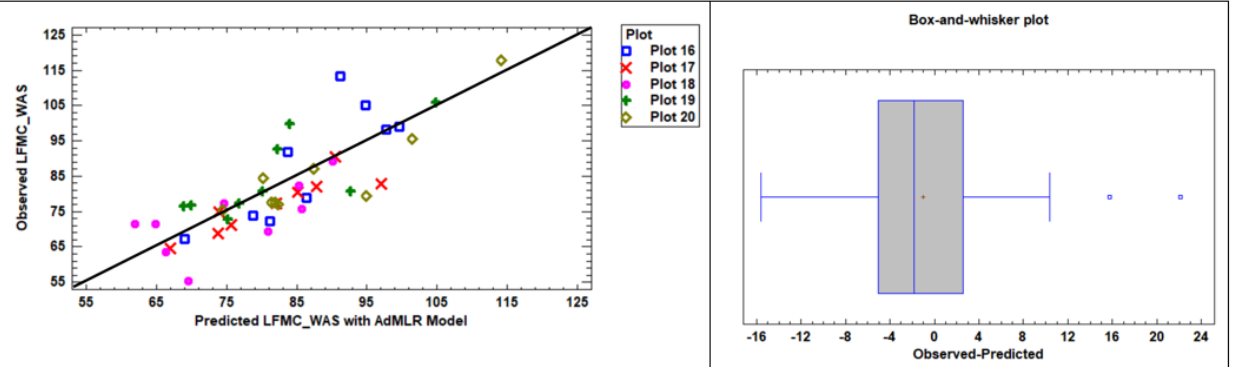
Figure 8. Scatterplot ( left ) and box-and-whisker plot ( right ) of errors between observed and predicted LFMC_WAS in plots of Table 2 (validation plots). Predicted values are obtained with Equation (5).